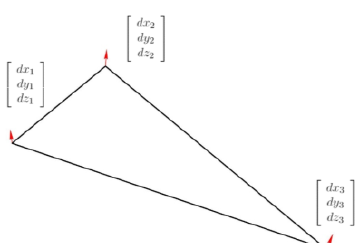
Figure 4. Each vertex of the triangle represents two homological points in the databases, while the red arrow shows the difference vector in size and direction, between the databases.